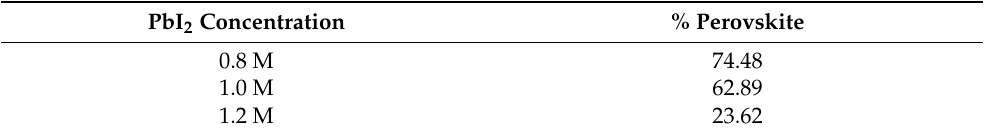
Table 1. Percentage of perovskite (MAPbI 3 ) content in the samples as a function of PbI 2 solution concentration .